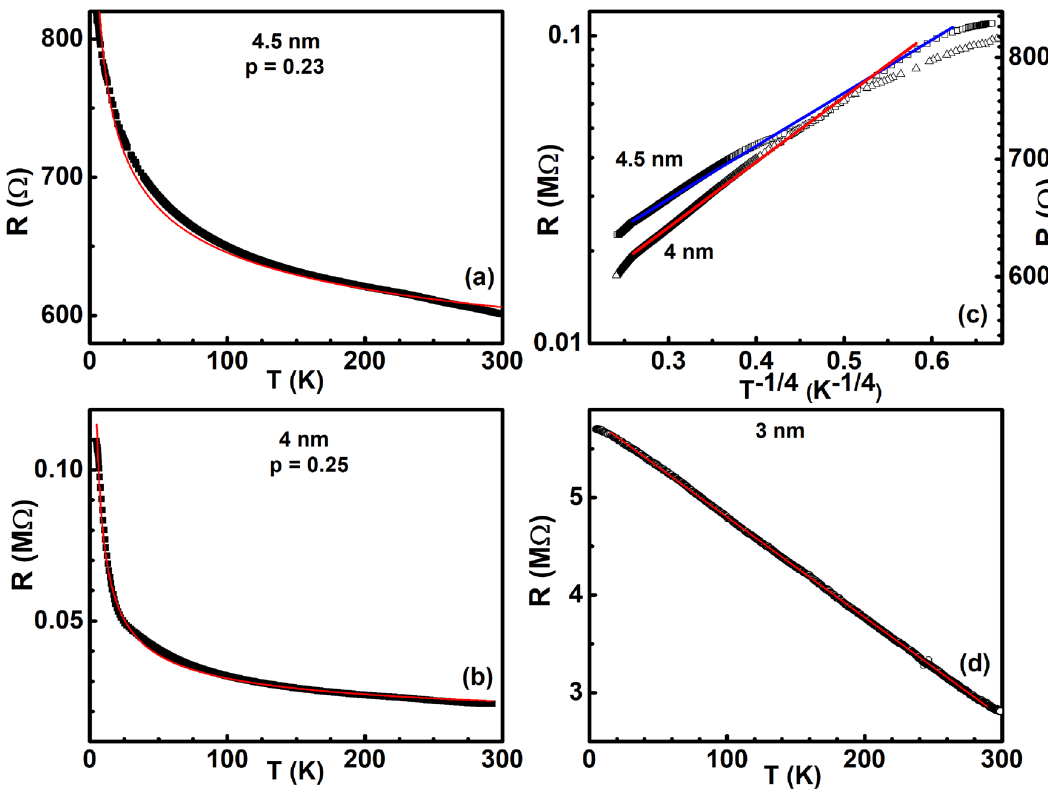
Figure 7. Black filled squares denote the temperature variation of resistance in ( a ) 4.5 nm and ( b ) 4 nm thin films. Red solid curves in each is a fit to Mott’s variable range hopping (See text for details). ( c ) log- linear variation of resistance with T − 1 ∕ 4 in films of thickness 4.5 nm represented by open triangles and 4 nm represented by open squares. Blue and red curves are straight line fits to the data corresponding to 4.5 nm and 4 nm thin film respectively. ( d ) Open circles represent the temperature variation of resistance in the 3 nm ultra- thin film while the red solid curve is a straight line fit to the